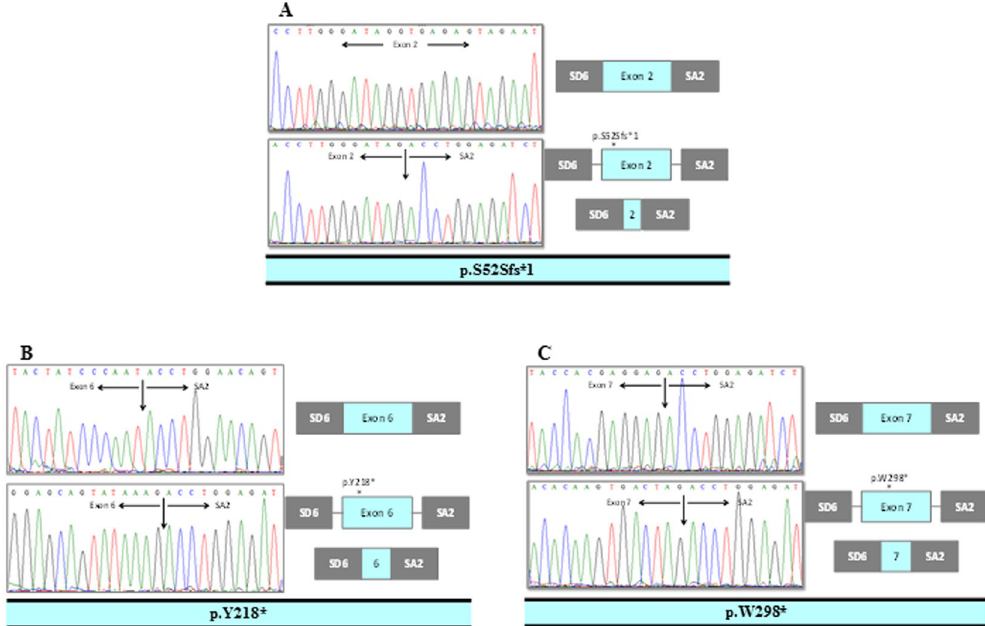
Figure 4. In vitro mRNA processing for frameshift mutation (p.S52Sfs * 1) and nonsense mutations (p.Y218 * and p.W298 * ) that produce a premature stop codon in the BMPR2 gene, as